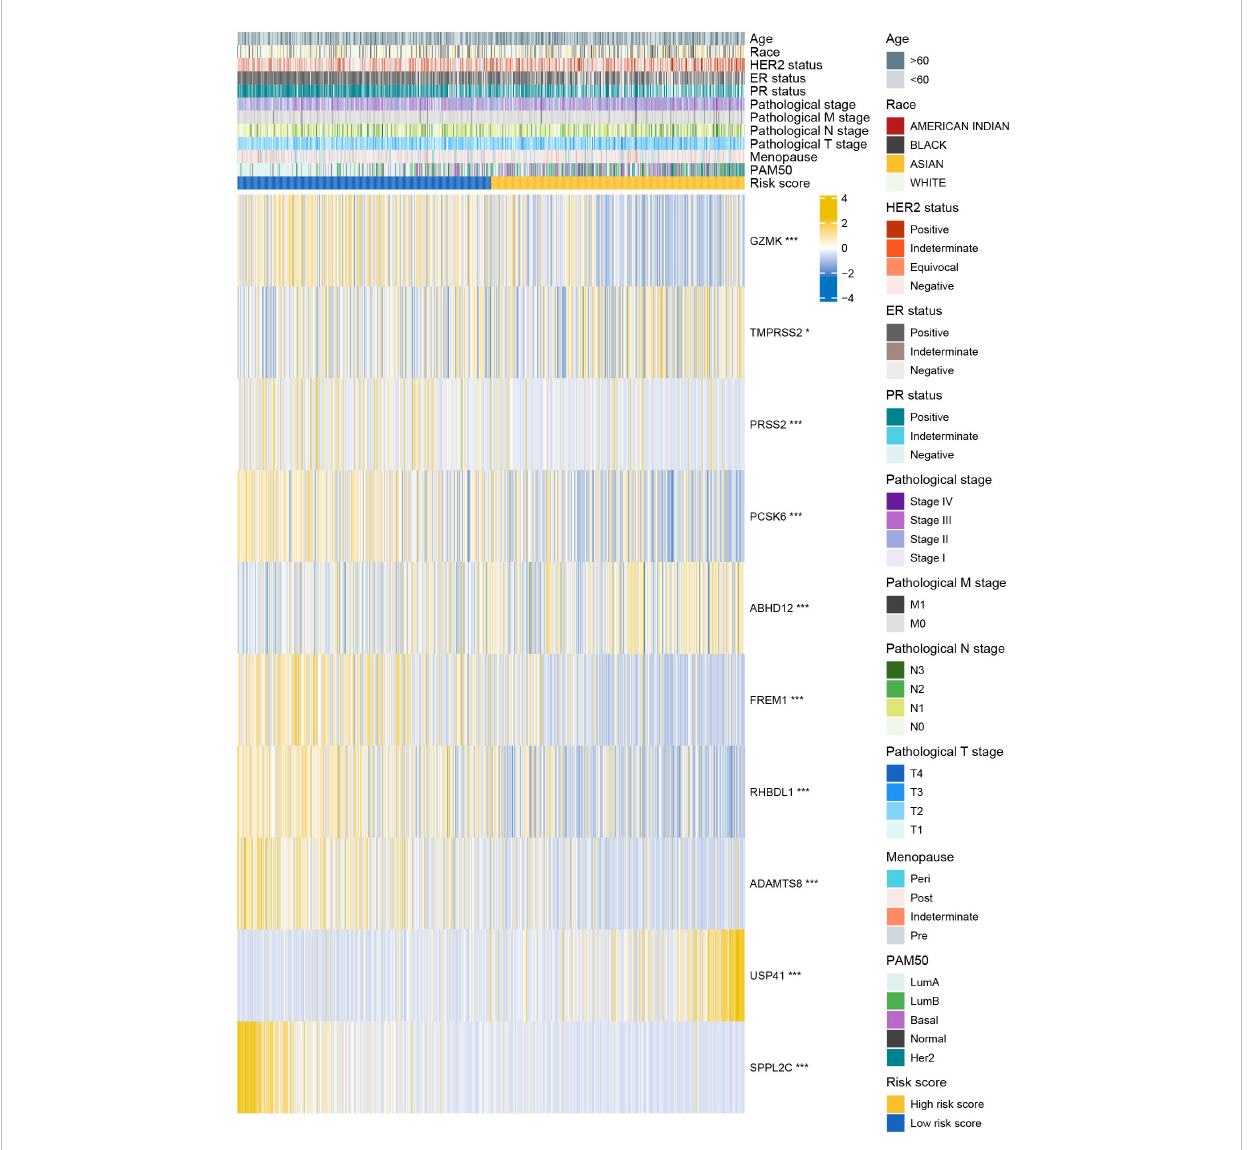
FIGURE 4 Distribution of clinicopathological characteristics in the low- and high-risk